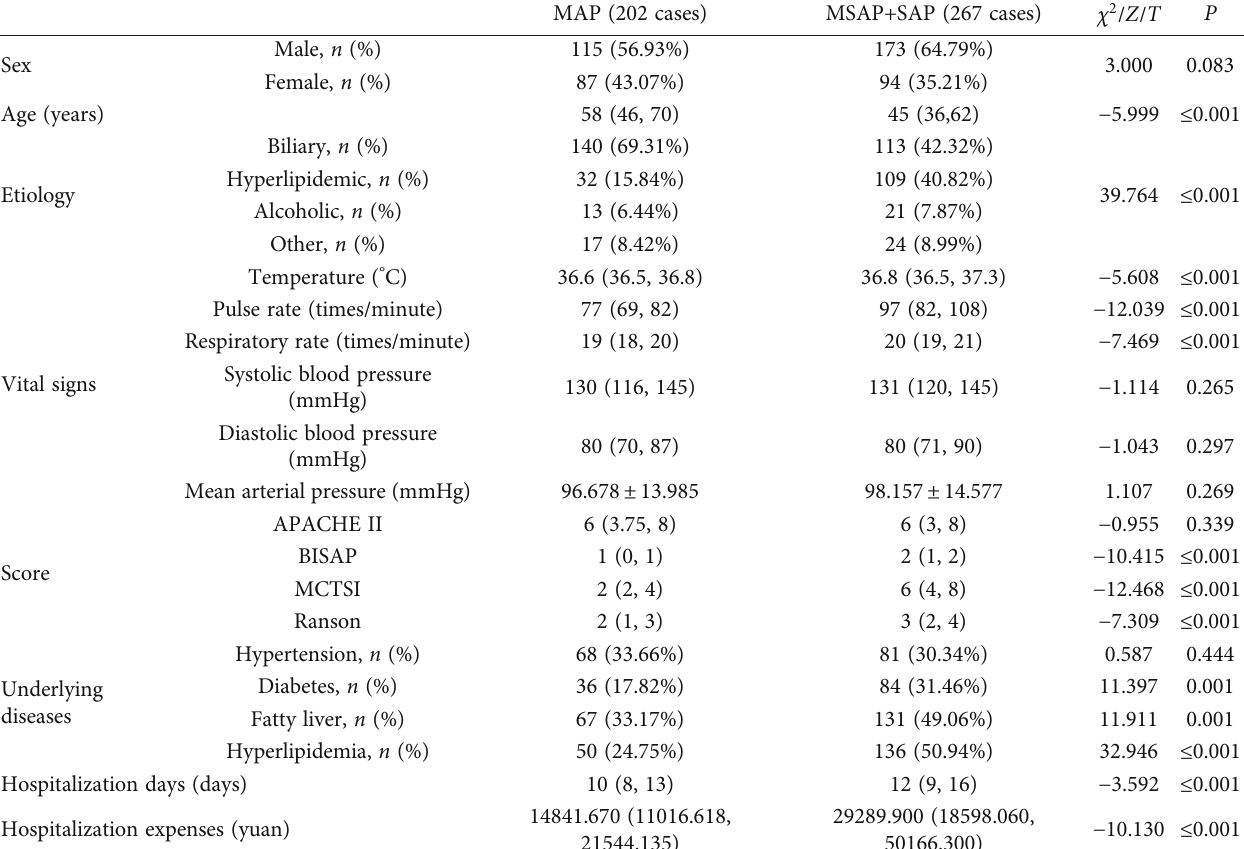
Table 1: Comparison of general data between the MAP and MSAP+SAP